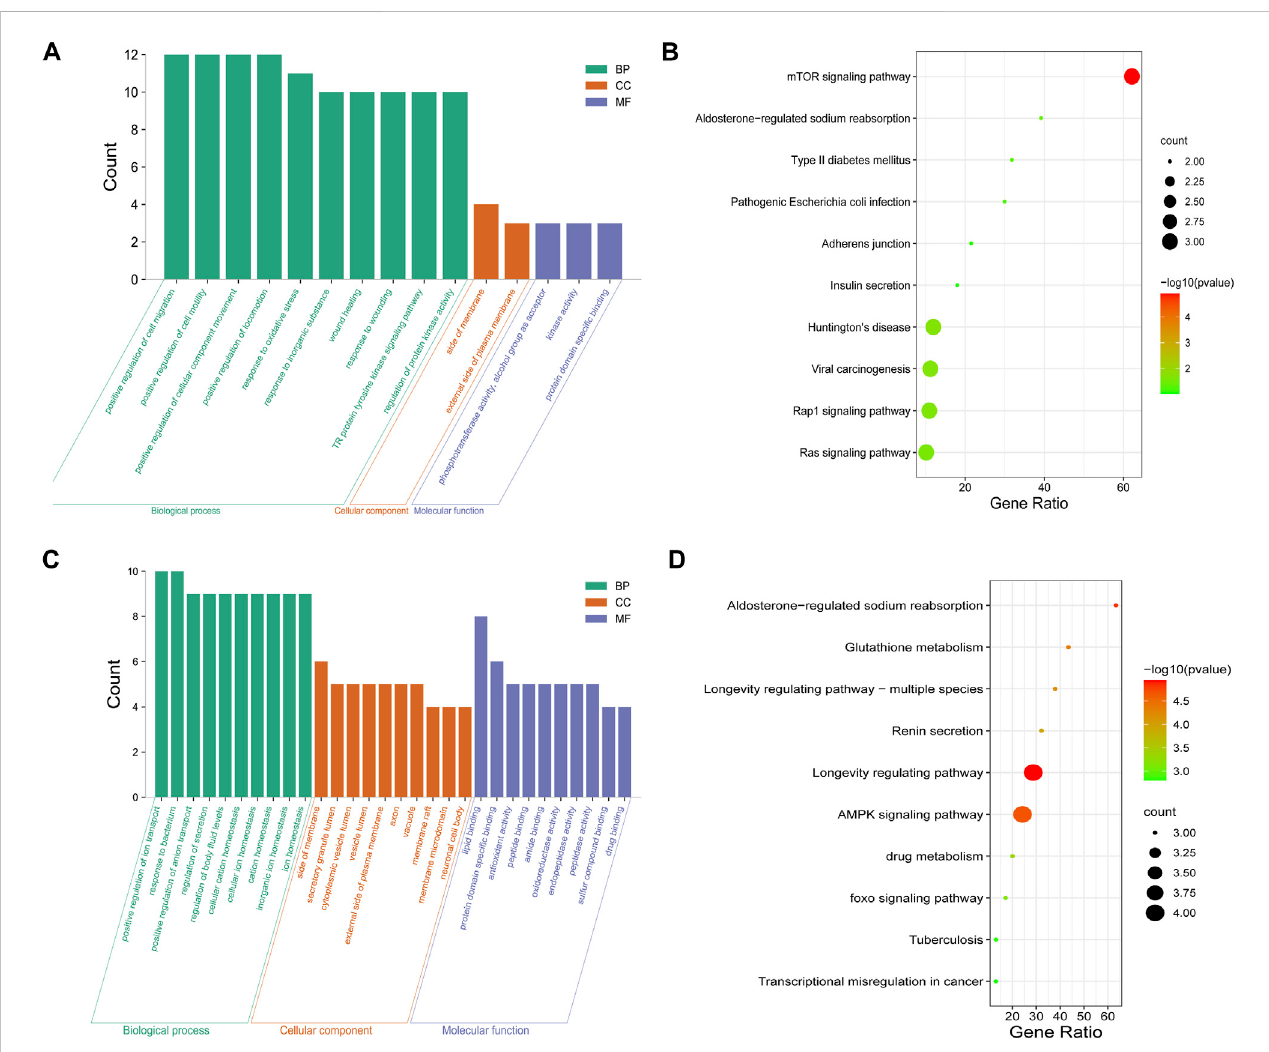
FIGURE 6 GO and KEGG enrichment of Forsythiaside-disease targets. (A) GO and (B) KEGG enrichment analysis of potential targets that Forsythiaside acting on diabetic podocytopathy. (C) GO and (D) KEGG enrichment analysis of potential targets that Forsythiaside acting on diabetic tubulopathy.